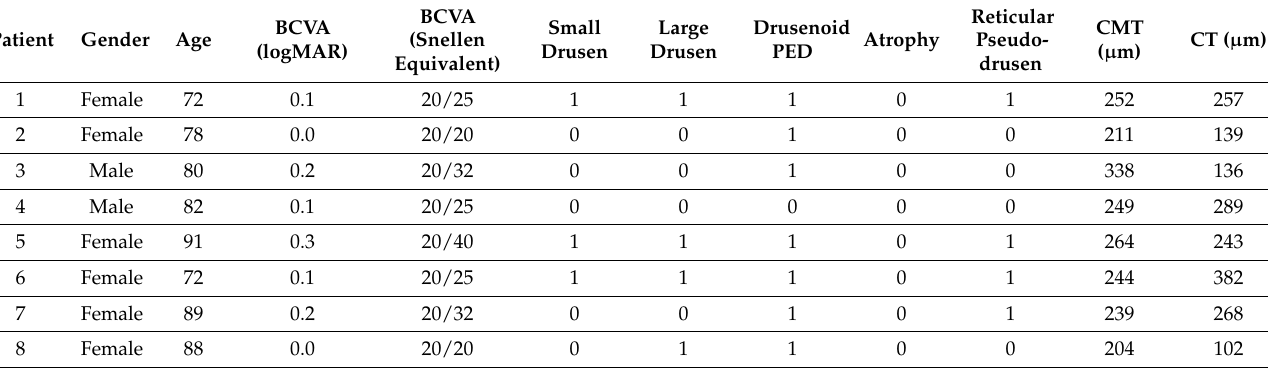
Table 1. Demographics, clinical findings, and multimodal imaging features of patients ( n = 8) with subclinical non-exudative macular neovascularization on the study eye.